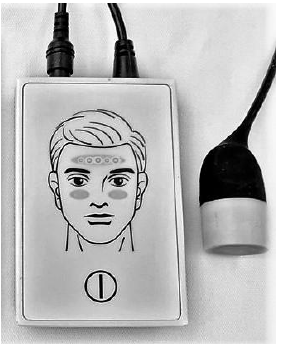
Figure 1. AxioSonic multimodal frequency treatment device.